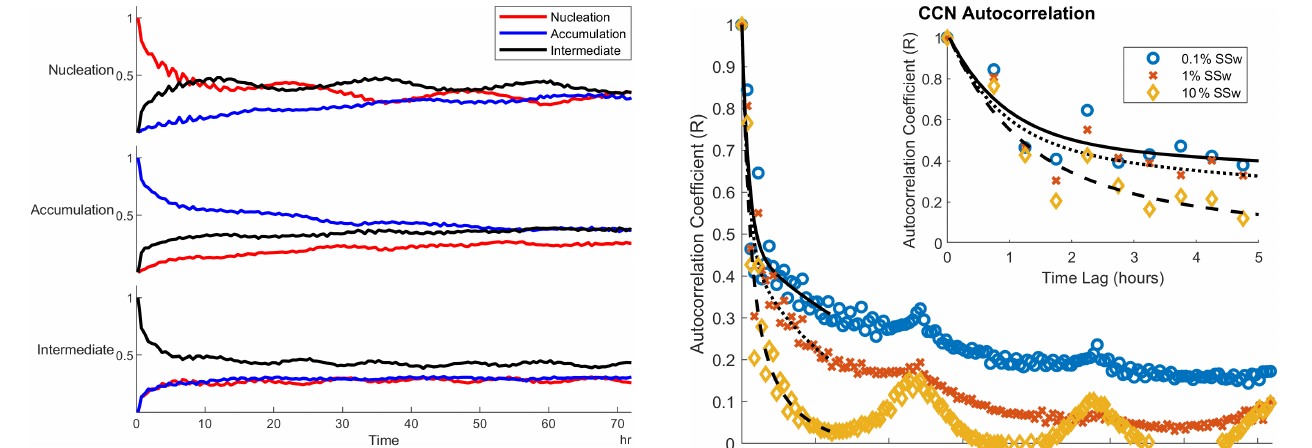
Figure 9. Cluster evolution over time (hours after the appearance of a cluster). The y axis for each plot shows the likelihood of the clus- ter transitioning to a new cluster type after a specified time, while the x axis has elapsed. The first collection of traces labeled nucle- ation shows the evolution of the nucleation cluster spectra into the other categories, with the middle collection depicting the evolution of accumulation cluster initial states and the bottom showing evo- lution of intermediate cluster initial states. Traces indicate the final states (after the specified time lag) of the nucleation cluster (red), accumulation cluster (blue), or intermediate cluster (black).